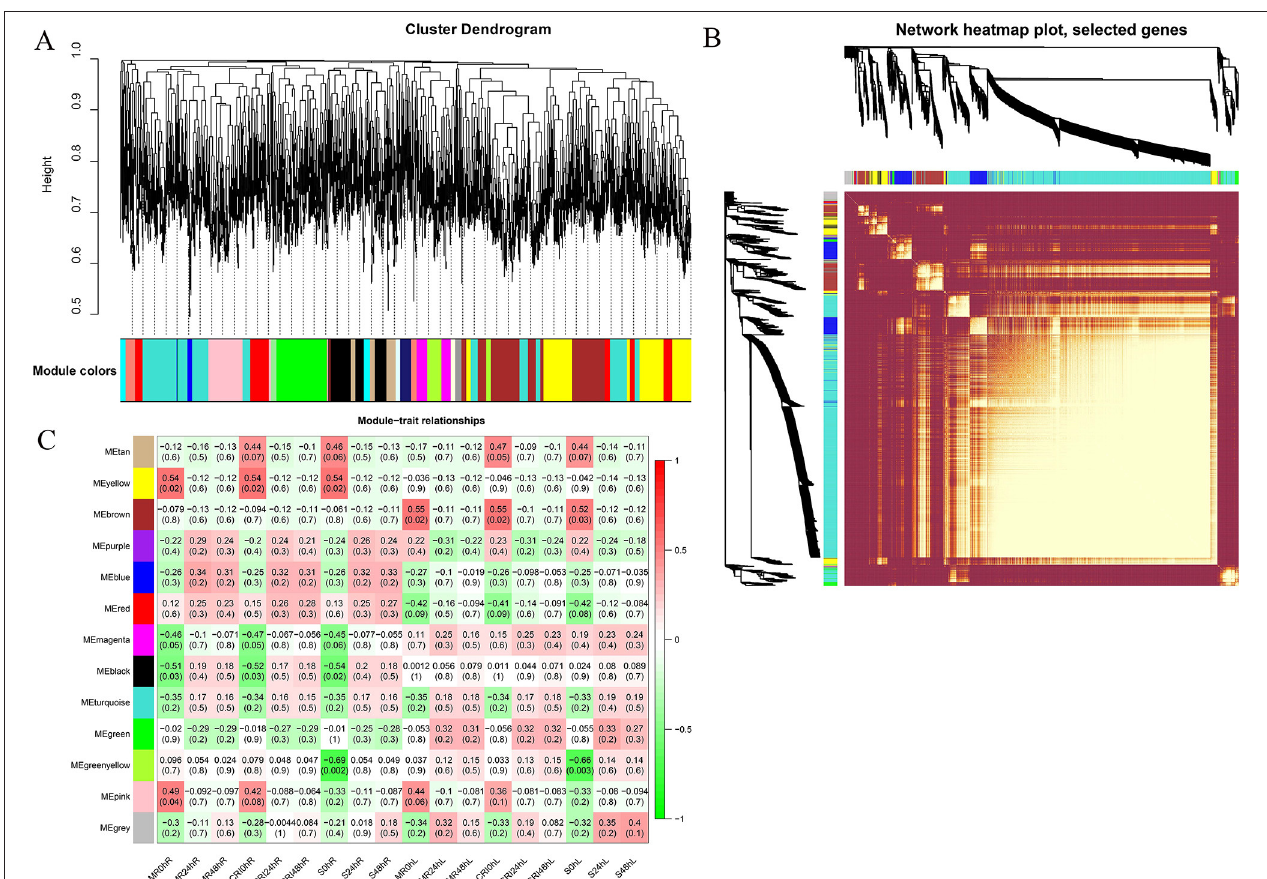
FIGURE 3 | WGCNA revealed gene networks and major candidate genes for drought (A) Network building of three upland cotton accessions using cluster dendrograms. (B) Heatmap of the network of genes that were subjected to the coexpression module calculation. (C) Pearson correlation-based module-trait relationships. From green to red, the color key symbolizes r 2 values ranging from − 1 to 1. Because of the highest weight inside the module, each network’s hub genes are indicated in red and gene descriptions are coded using annotations. WGCNA, Weighted gene co-expression network analysis.